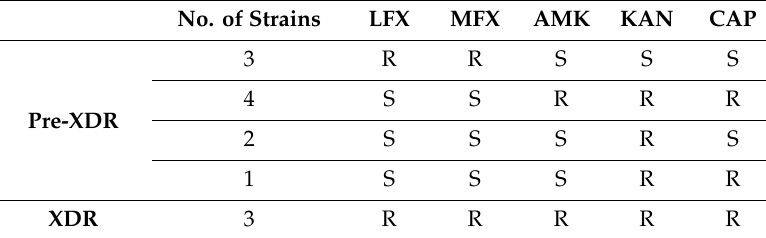
Table 1. Resistance pattern of pre-extensively drug-resistant (pre-XDR) and extensively drug-resistant (XDR) strains.